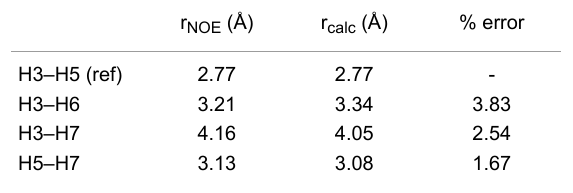
Table 1: NOE-derived and ensemble-averaged interproton